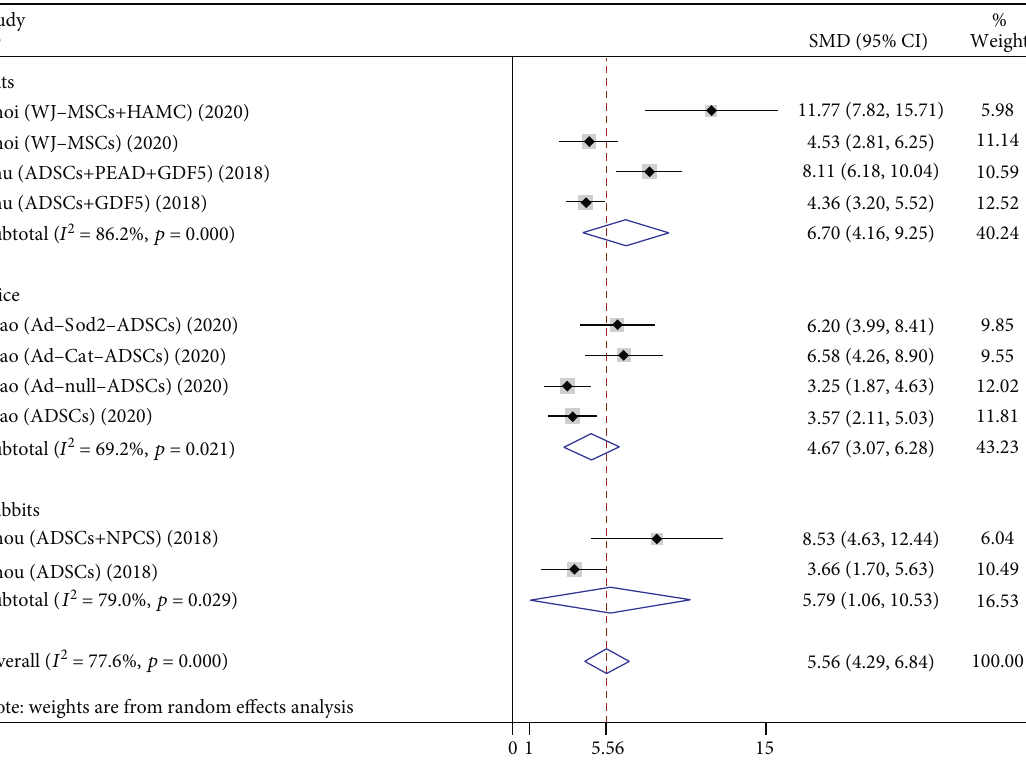
Figure 5: Forest plot showing the e ff ect of stem cell group and control group on MRI index in animal models.